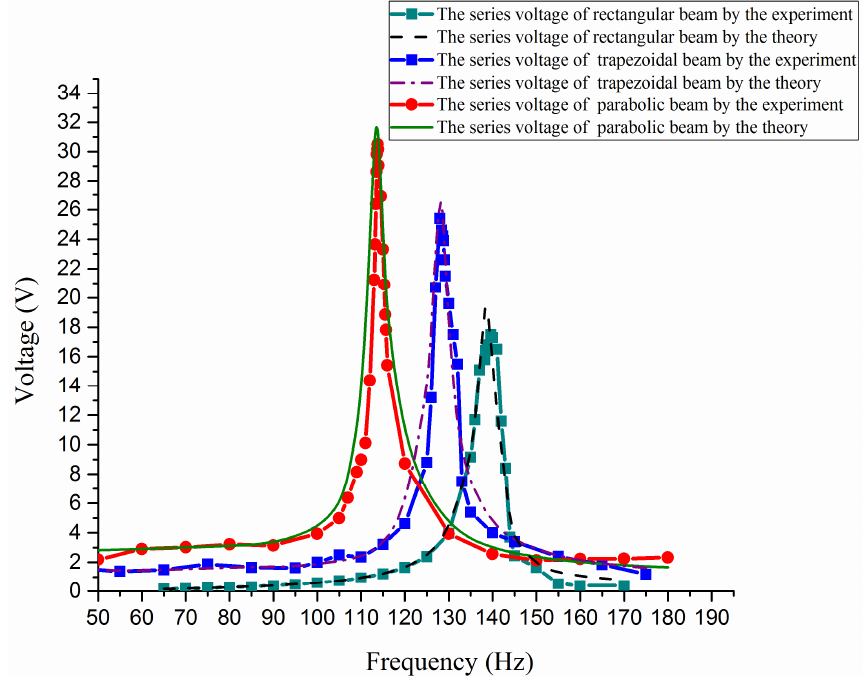
Figure 7. Open circuit voltage outputs versus exciting frequencies.